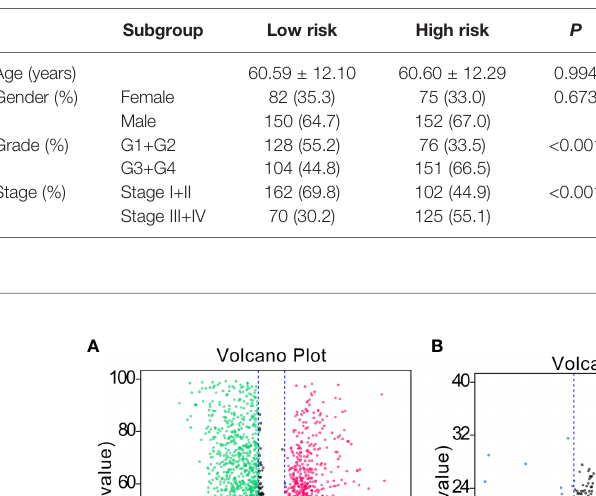
TABLE 2 | Summarization of clinical features.